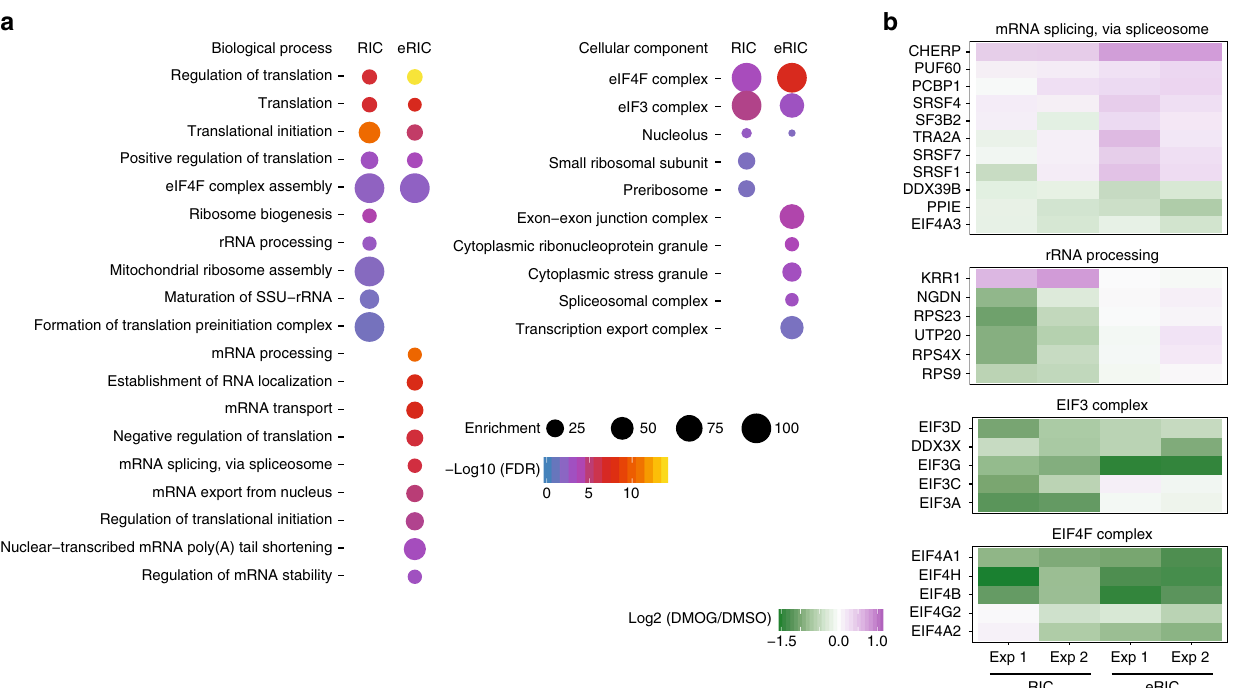
Fig. 6 Improved detection of poly(A)RBP responses by eRIC. a Representative biological processes and cellular components enriched among the DMOG- responsive RBPs identi fi ed by eRIC and/or RIC (Fisher ’ s Exact with FDR multiple test correction). b Examples of protein complexes or functionally related proteins that respond to DMOG with statistical signi fi